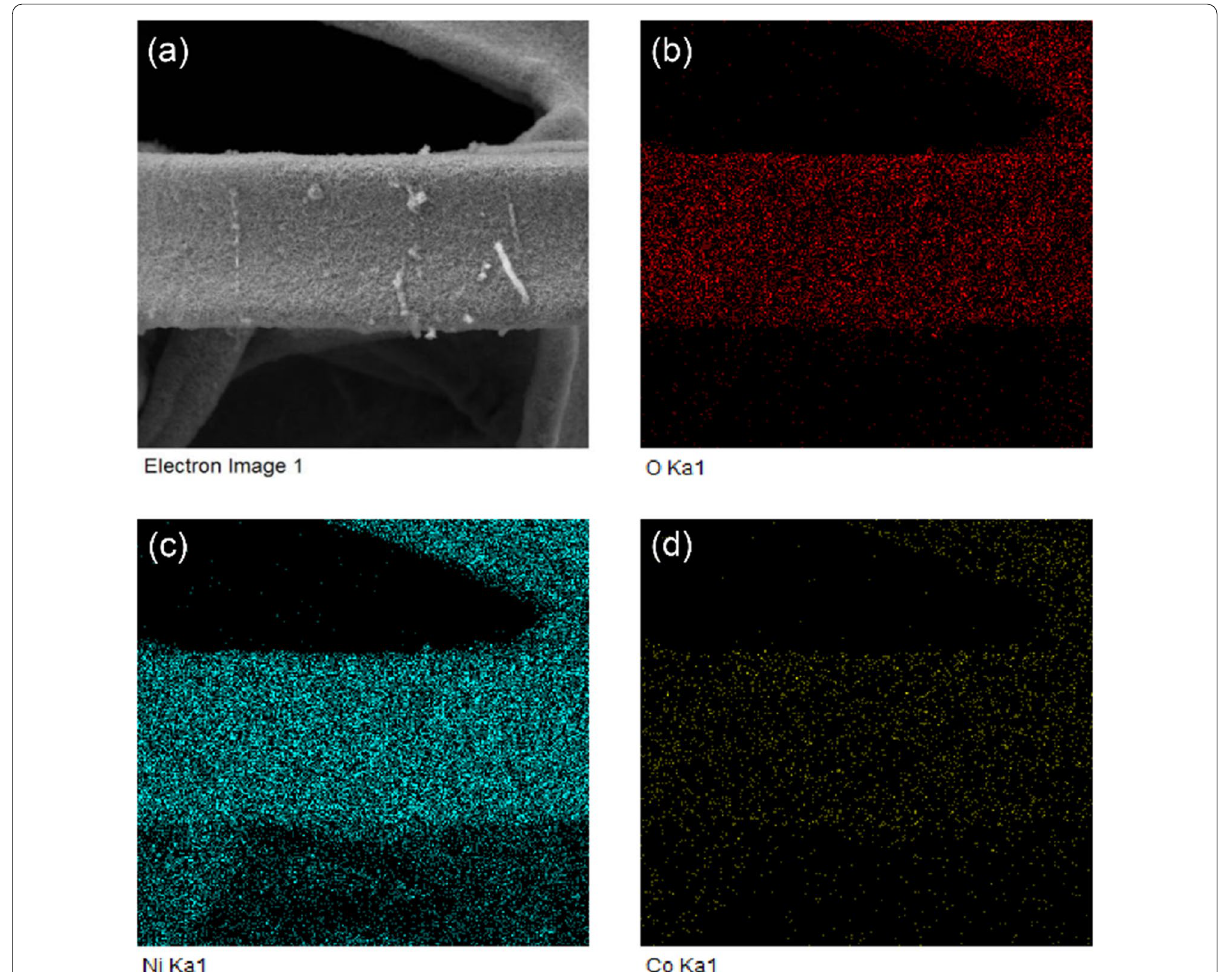
Fig. 4 a SEM of NiCo-LDH-1; EDS element mapping diagrams of b Ni, c Co and d O in